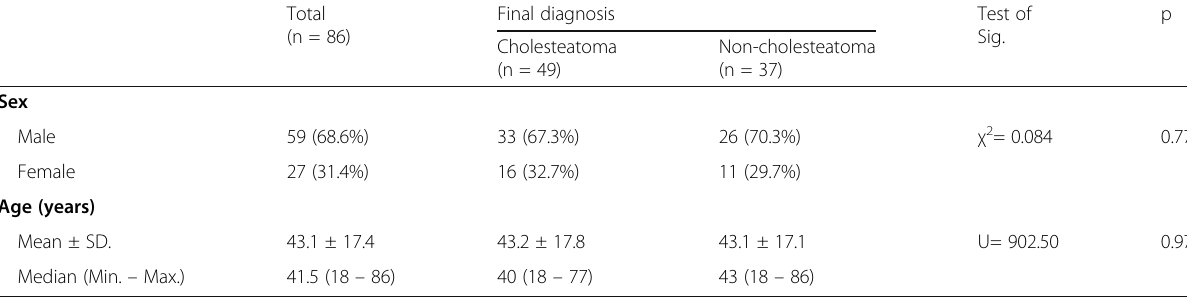
Table 1 Comparison between the cholesteatoma and non-cholesteatoma according to age and sex